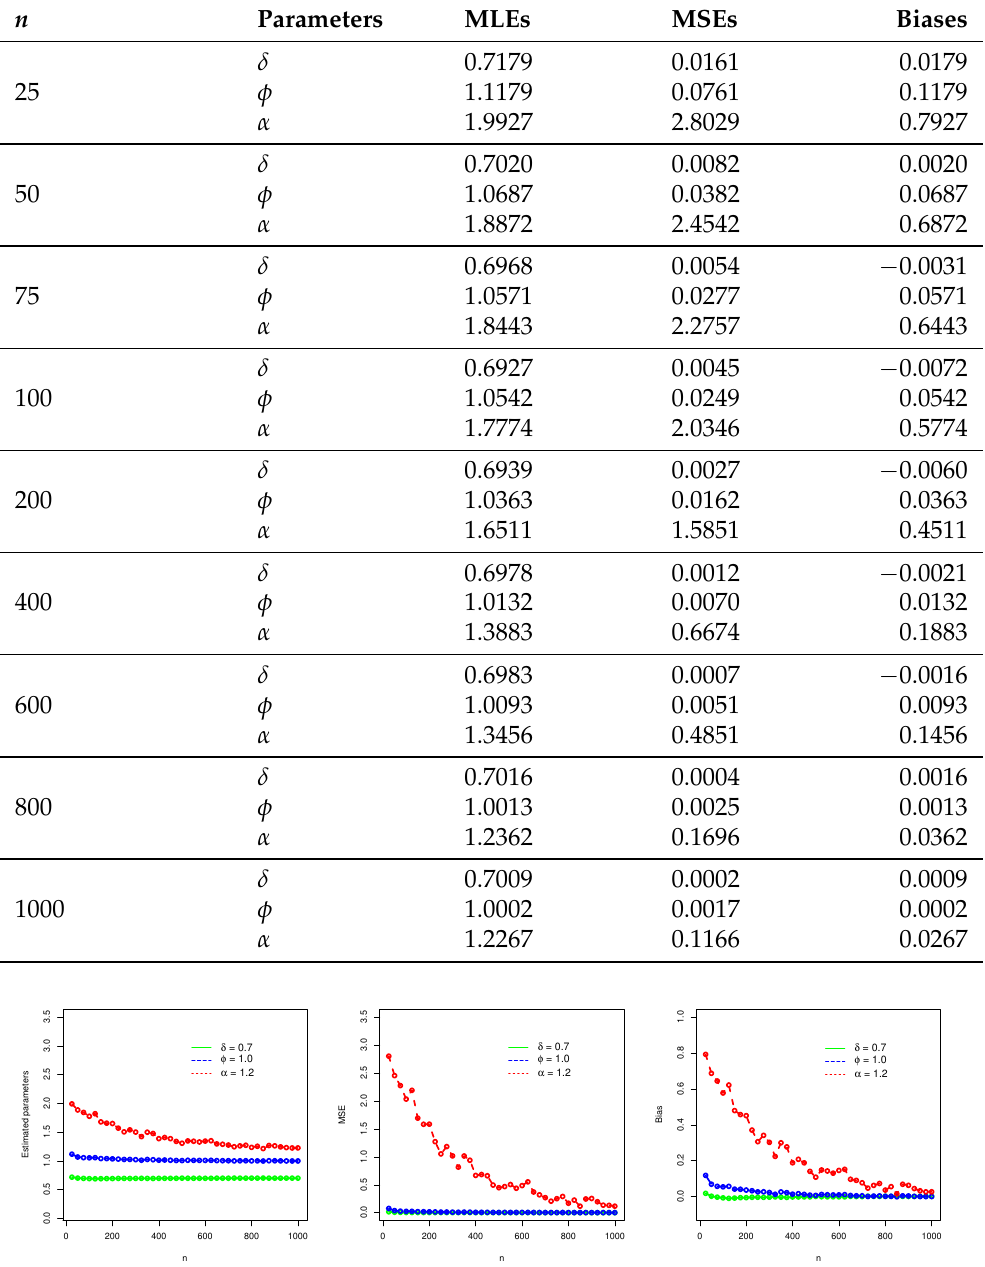
Table 1. The numerical illustration of the SS of the NACos-Weibull distribution for δ = 0.7, φ = 1.0, and α = 1.2.